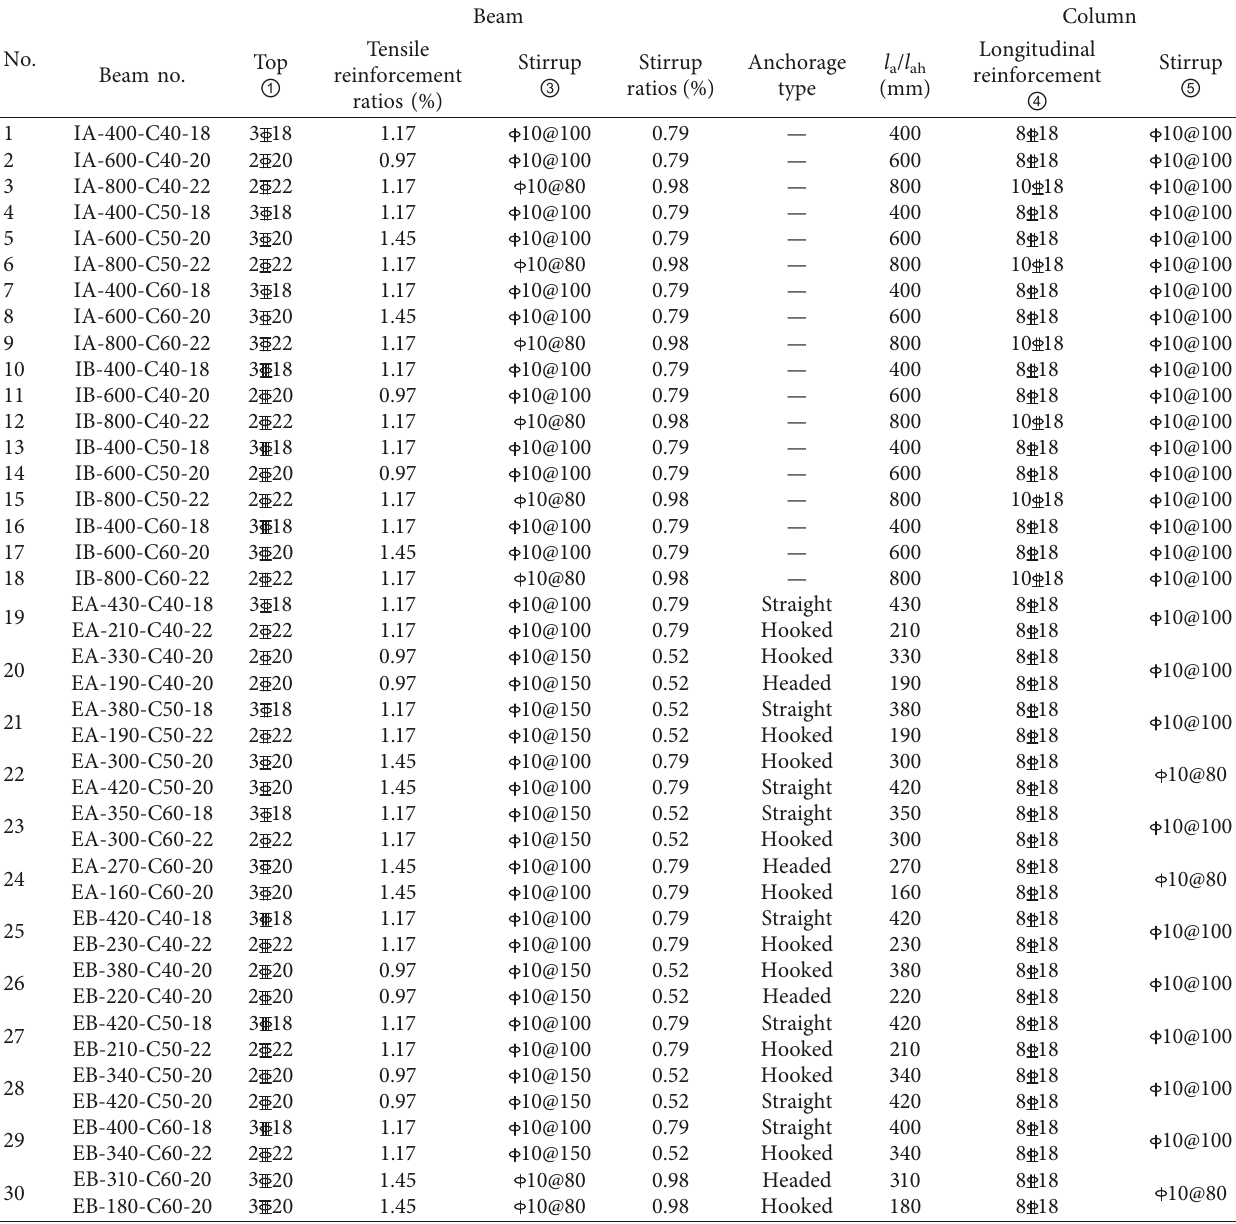
Table 1: Reinforcement of the test specimens.